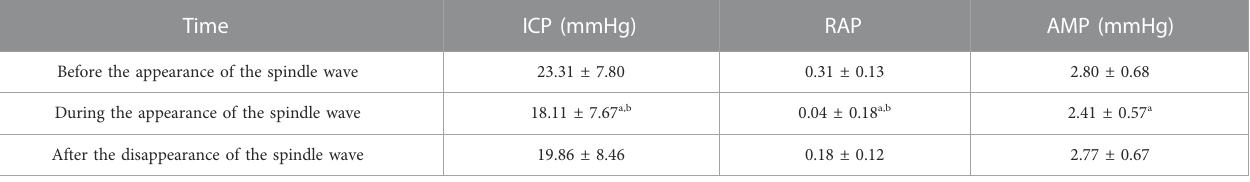
TABLE 2 Comparative results of parameters before, during, and after the spindle wave in patients with traumatic brain injury (TBI) (mean ± standard deviation).